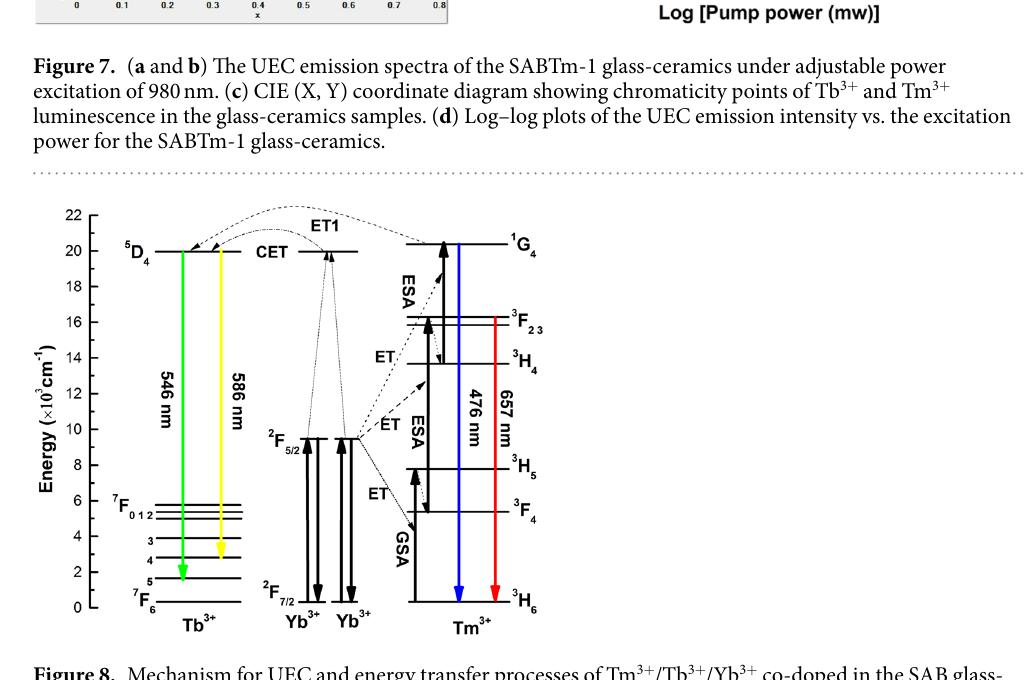
excitation. In addition, it was also proved that energy transfers during the UEC process included the transfers from Yb 3 + to Tm 3 + and Tb 3 + , as well as the transfer from Tm 3 + to Tb 3 + . Our work suggests a possible route to design and develop the red, green and blue UEC luminescence materials by laser, and provides useful information for further development of UEC glass-ceramics associated with the energy transfer between Tm 3 + and Tb 3 + ions.